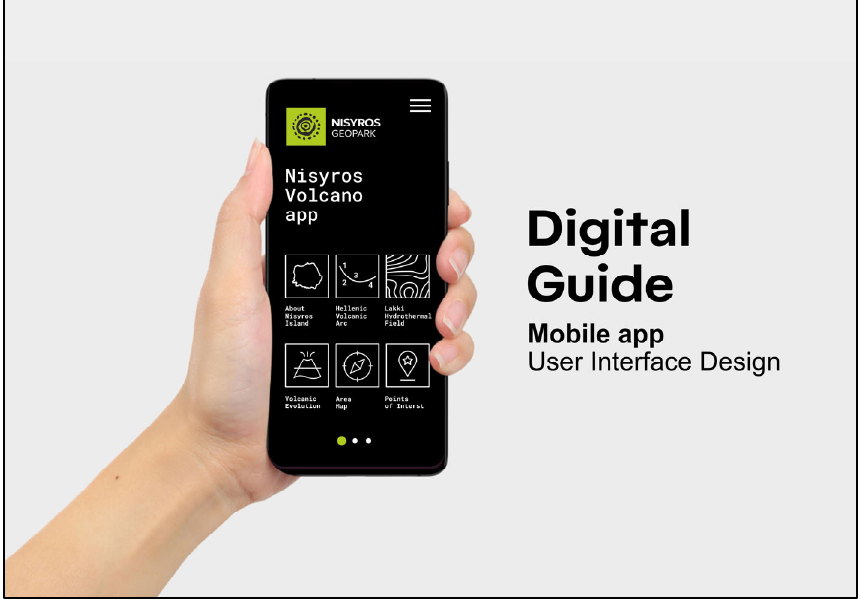
Figure 11. ‘Nisyros Volcano App’s’ main user interface design, with the icons representing a different subunit of the three total provided informational